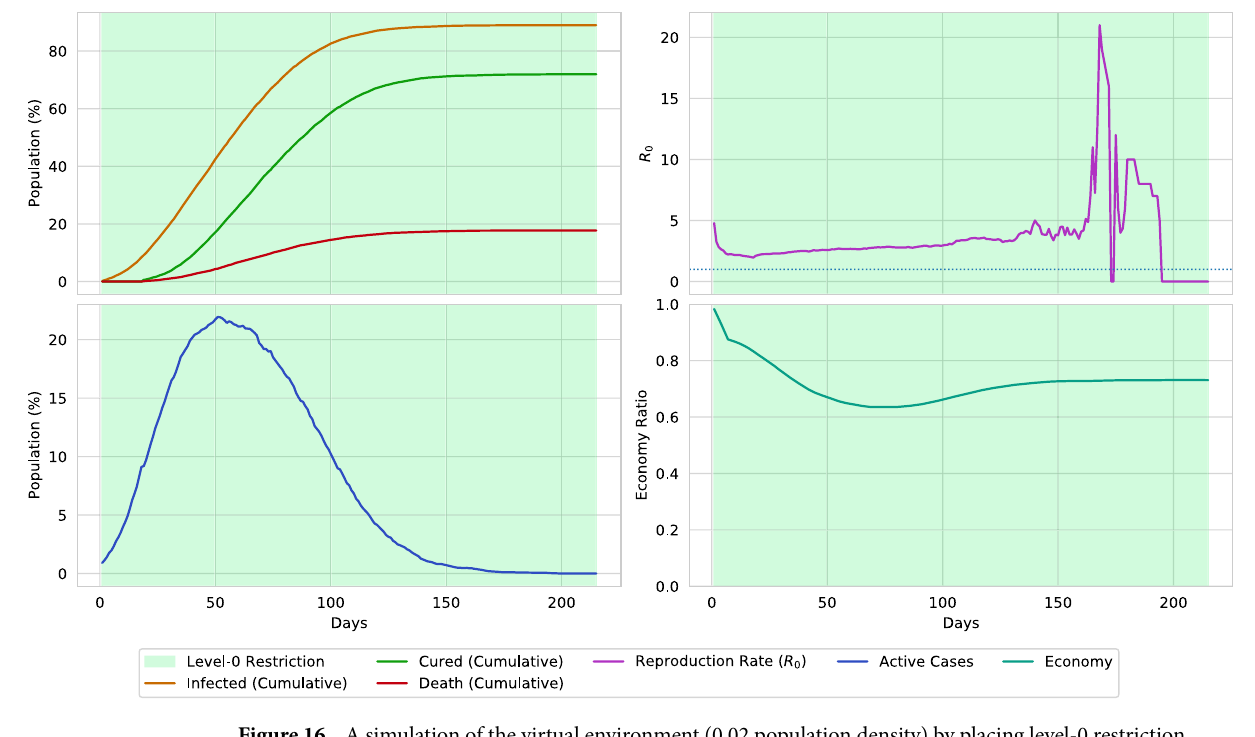
Figure 16. A simulation of the virtual environment (0.02 population density) by placing level-0 restriction. The upper-left portion illustrates the cumulative sum (in percentage) of infected, cured, and dead of the overall population. The upper-right portion illustrates the reproduction rate of the disease. The lower-left portion indicates the percentage of the active cases of the population. The lower-right portion determines the economical state through the spread of the disease. A massive surge of active cases is reported on reaching the 50th day of the pandemic. Around 20% of the population dies due to the disease if no lockdown is placed and no social-distancing is